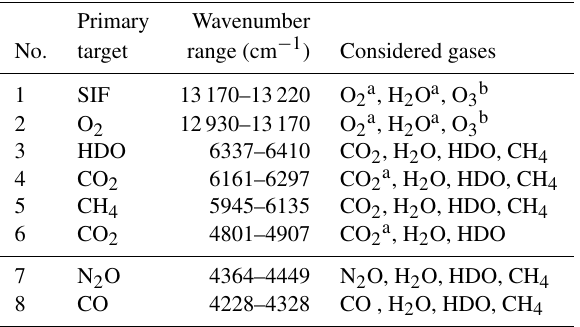
Table 2. Definition of GOSAT/GOSAT-2 spectral fit windows (same for S and P polarisation). Windows 7 and 8 are only available for GOSAT-2. Cross sections are from HITRAN2016 except for those marked with “ a ”, which are from ABSCO v5.1, and those marked with “ b ”, which are from Gorshelev et al. (2014) and Serdyuchenko et al. (2014).